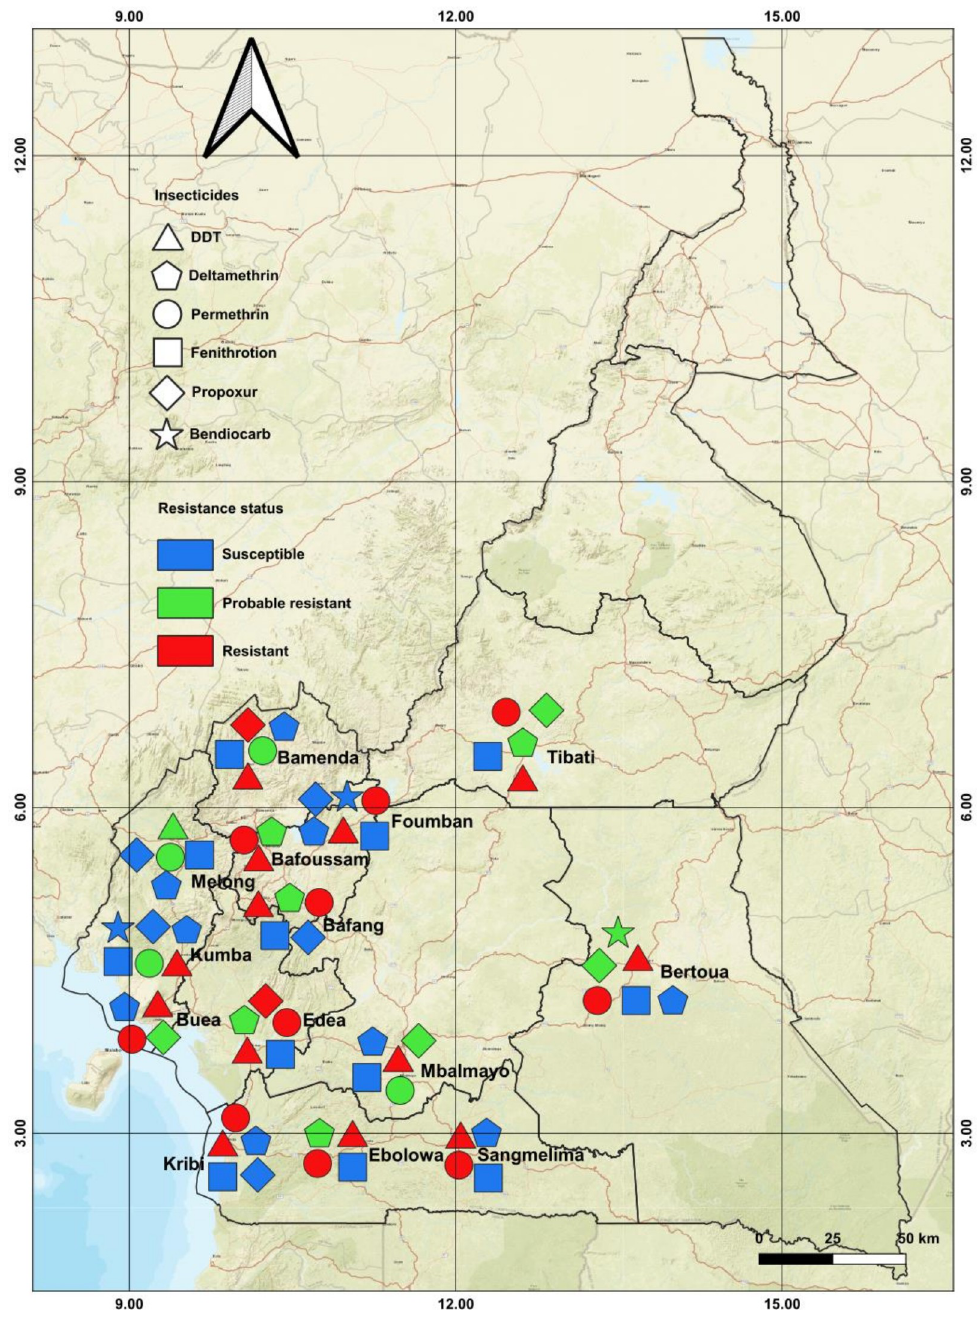
Fig 4. Map of Cameroon showing the insecticide resistance status of Aedes albopictus in 14 locations of Cameroon. DDT, Dichlorodiphenyltrichloroethane.